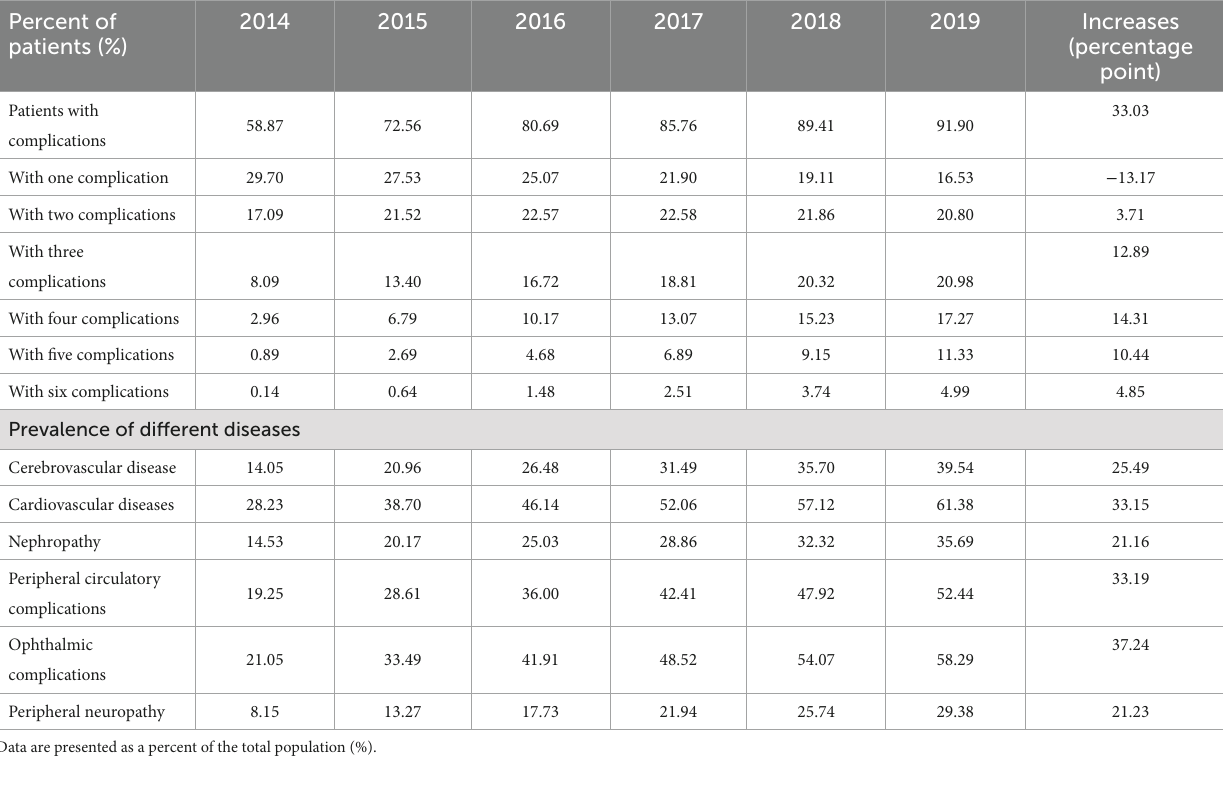
TABLE 2 Prevalence of diabetic complications and related diseases ( N = 44,994). Percent of patients (%)